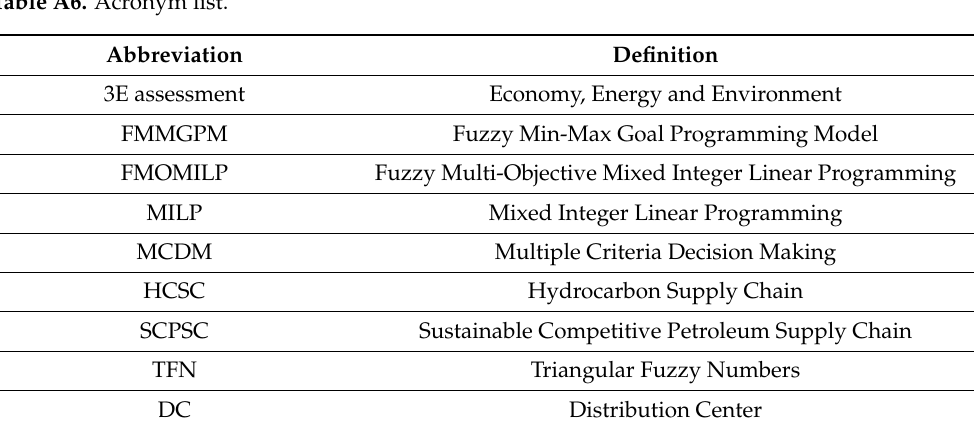
Table A6. Acronym